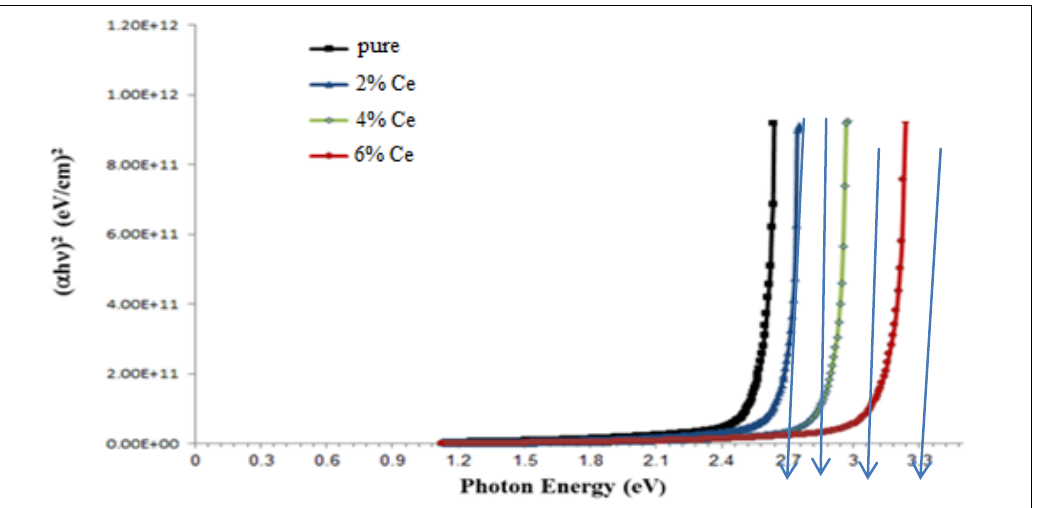
Fig. 13: Plot of (  h  ) 2 versus h  for CdO thin film at different concentration of